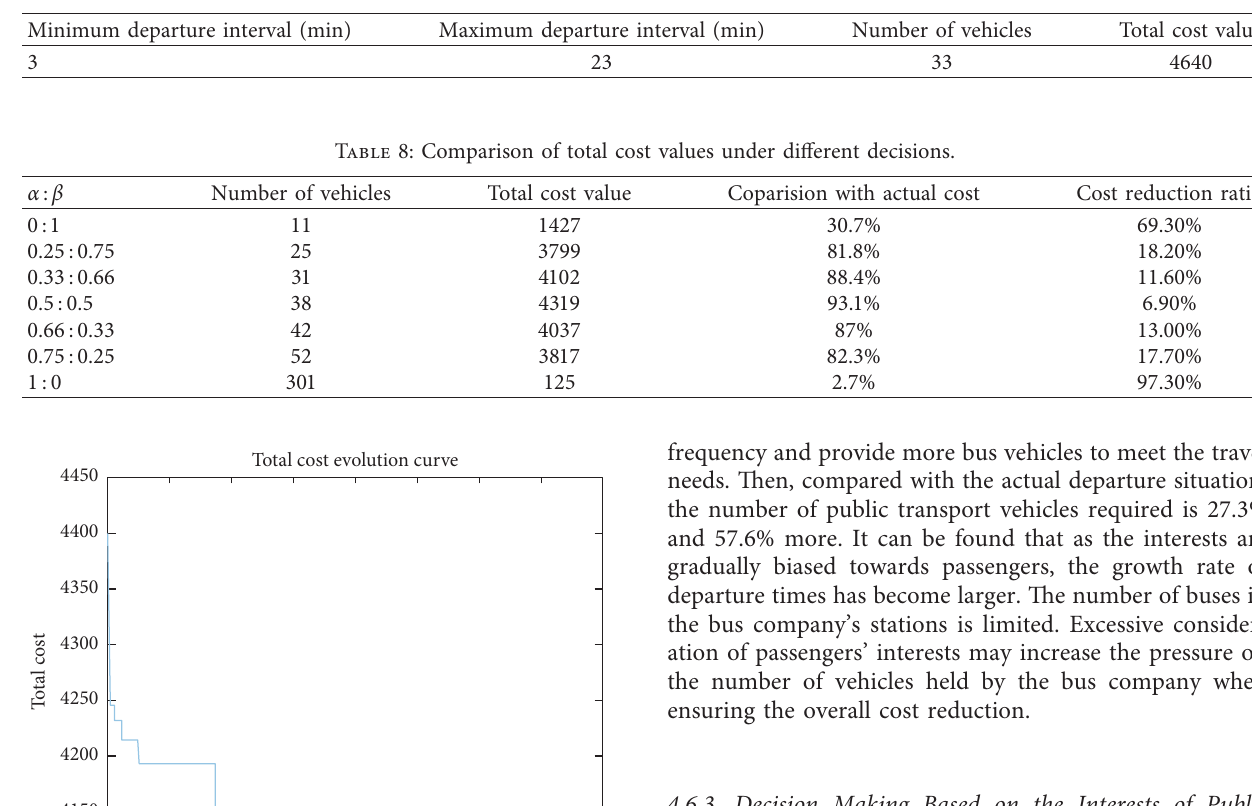
Table 7: Actual line schedule.